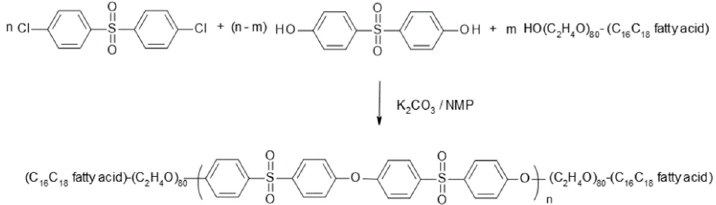
Figure 2. Synthesis mechanism of the amphiphilic triblock copolymer of type PEO-PESU-PEO.